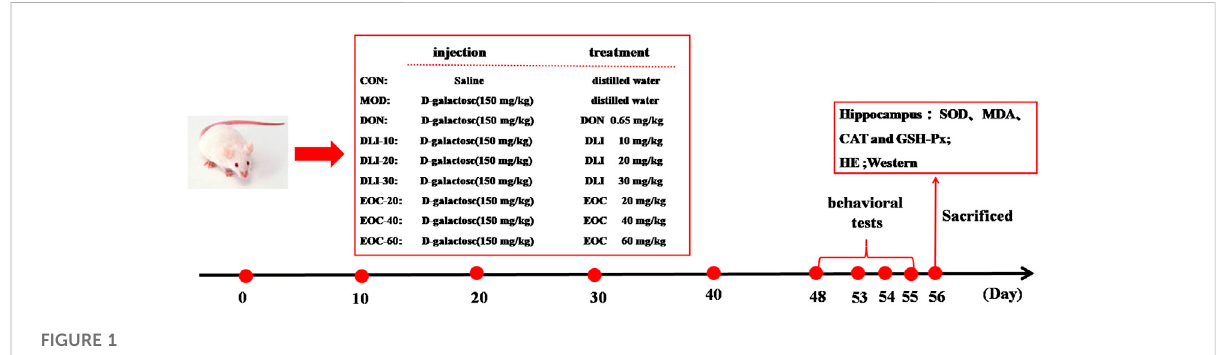
FIGURE 1 Animal experiment